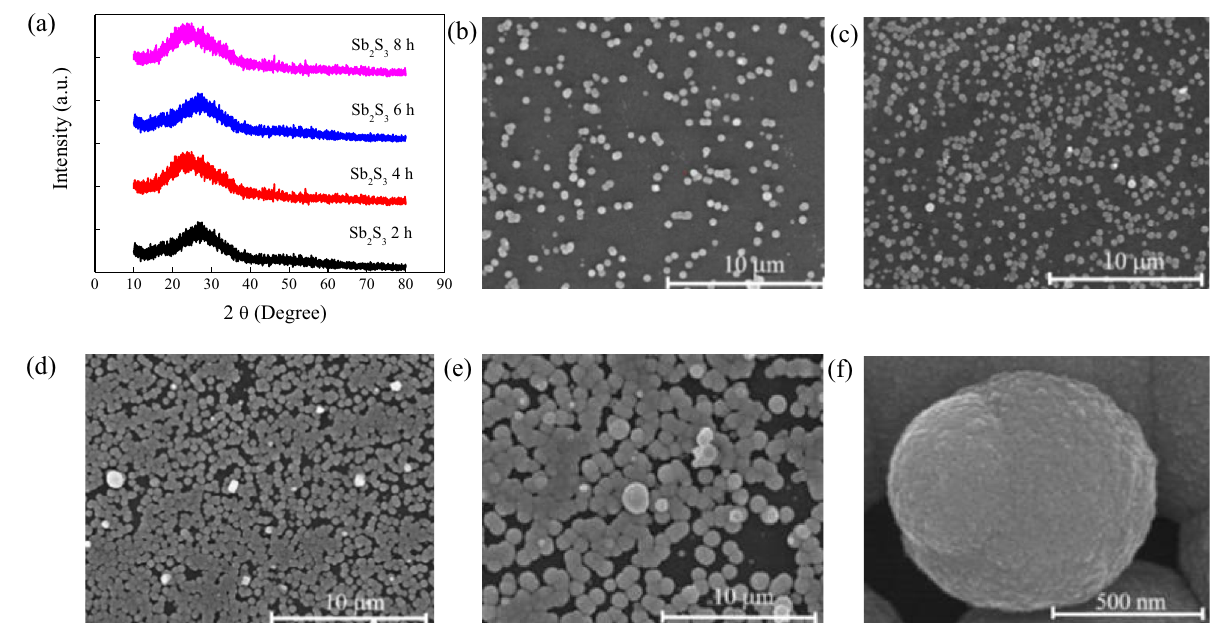
Figure 3. ( a ) The XRD patterns of 10 min UV irradiation time of graphene with 2, 4, 6, and 8 h Sb 2 S 3 deposition time, respectively. ( b – e ) SEM top view of Sb 2 S 3 film at 2, 4, 6, and 8 h CBD growth time, respectively. ( f ) A single particle of Sb 2 S 3 for 8 h CBD growth